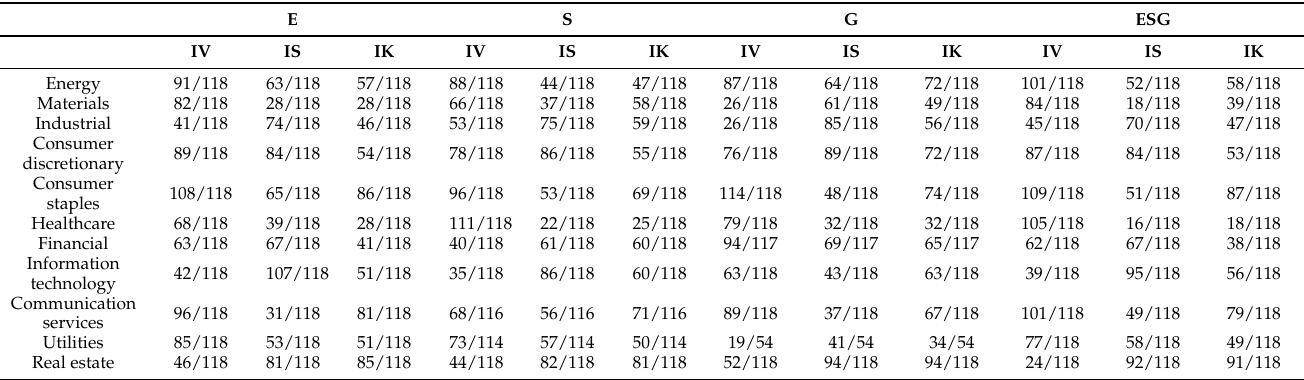
Table 4. Number of months during which companies in the high ESG rating group have fewer implied moments than those in the low ESG rating group. Group-dividing standard is the median value of ESG ratings.